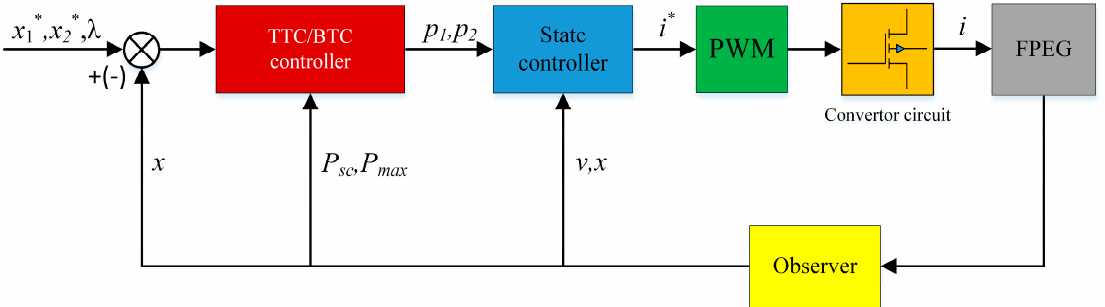
Figure 11. Top turning center (TTC) control and bottom turning center (BTC) controller model.